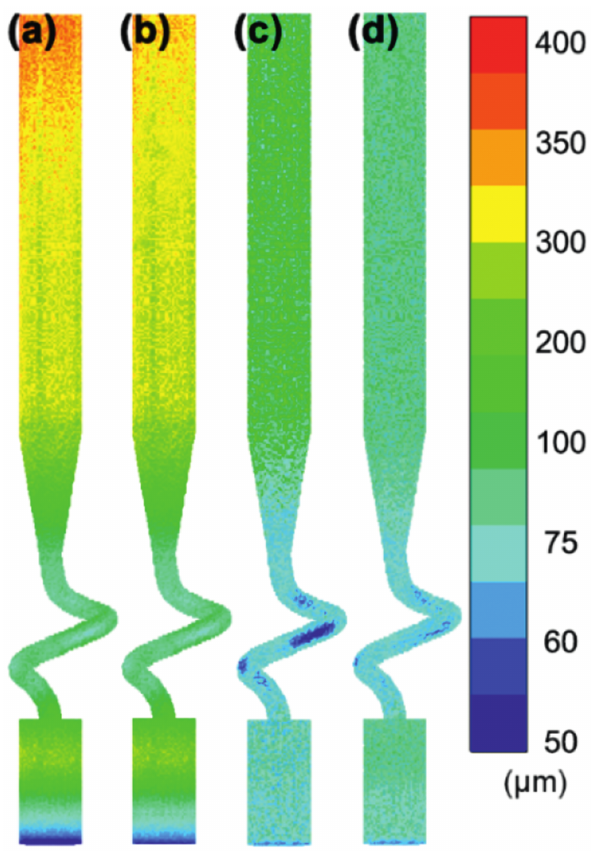
Figure 10: Morphology of the dendritic arm spacing: (a) PDAS in the HRS process; (b) PDAS in the LMC process; (c) SDAS in the HRS process; and (d) SDAS in the LMC